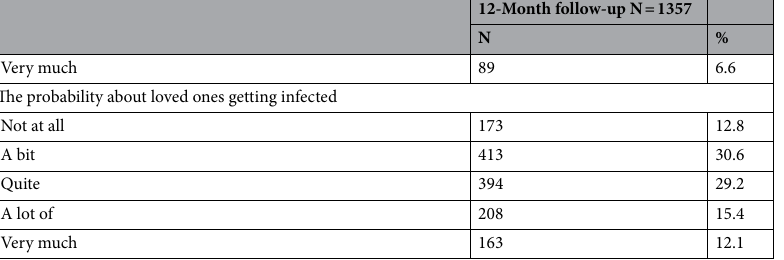
Table 2. Sample characteristics during the COVID-19 pandemic (at 12-month follow-up) of factors associated and stress-related with COVID-19 after weighting. Q 1 , First quartile ; Q 3 , Third quartile. % weighted follow-up sample weight (inverse probability weighting and post-stratification).